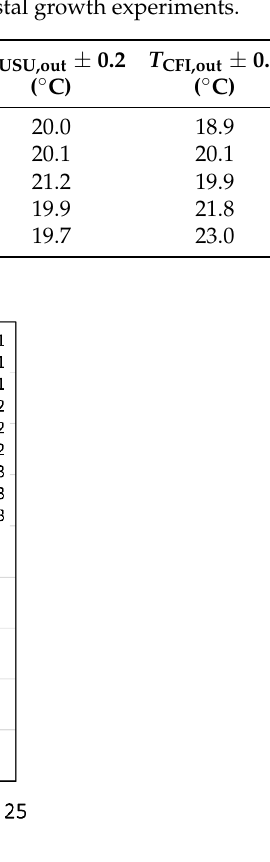
Figure A4. Temperature profile for combined nucleation and crystal growth experiments 1–3; the dashed lines only serve better visualization.